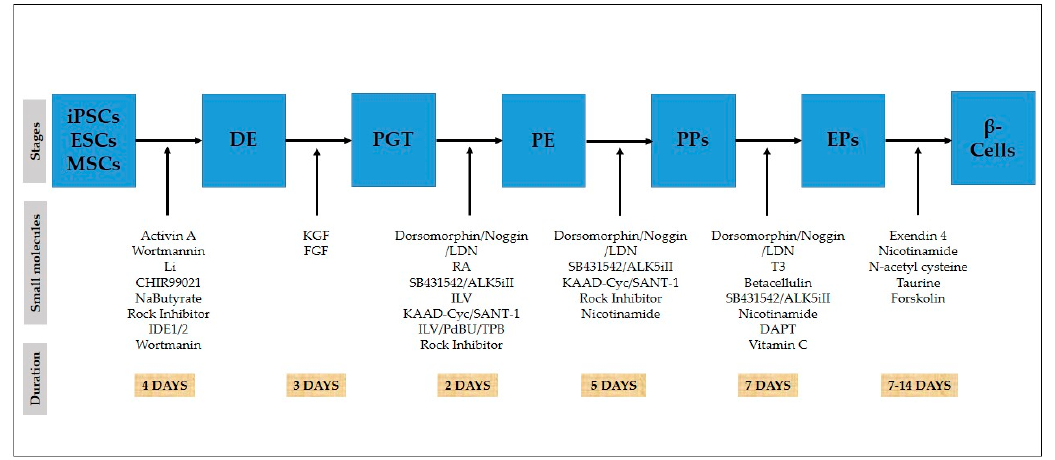
Figure 2. In vitro differentiation of stem cells towards pancreatic β -cells. Timeline of differentiation of stem cells transforming small molecules into β -cells. Table 2. Role of di ff erent transcriptional factors in pancreatic endocrine cell